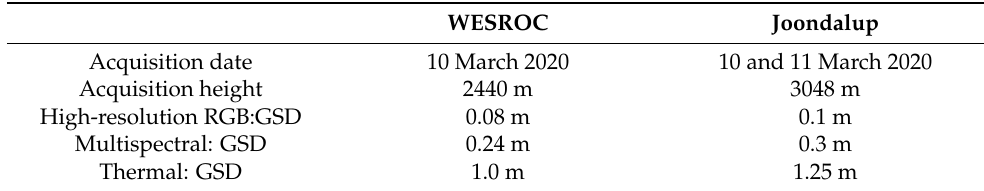
Table 2. Acquisition parameters and resulting image Ground Sample Distance (GSD) for each of the imaging sensors for the two study areas.